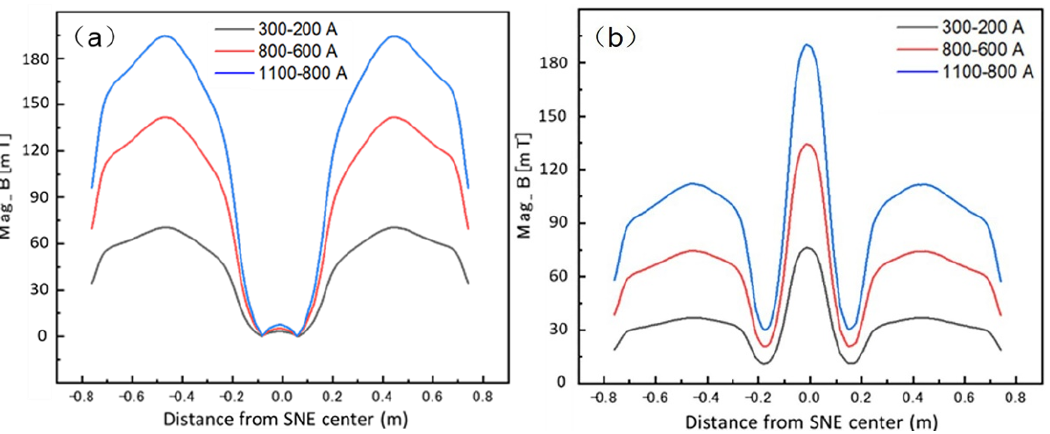
Figure 10. Numerical simulation results of different currents. ( a ) Feature line 1 and ( b ) feature line